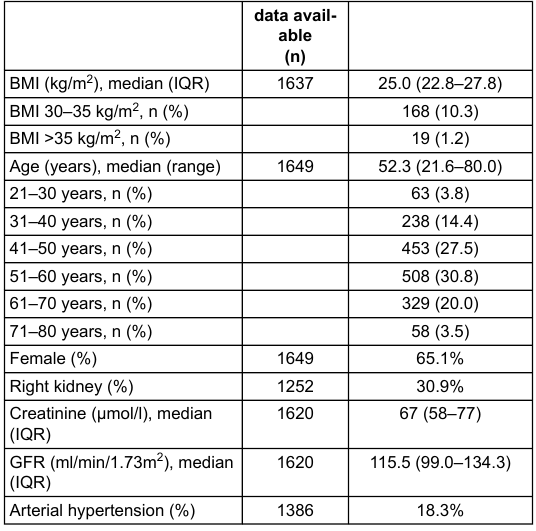
Table 1: Baseline characteristics.